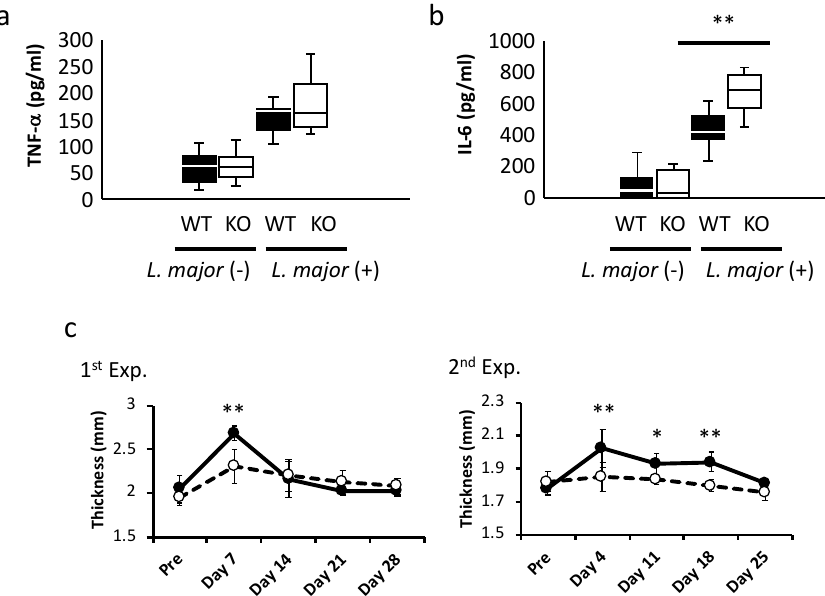
Figure 5. Leishmania ( Leishmania ) major infection in vitro and in vivo. BMDCs from WT and KO mice were infected with L. ( L. ) major . After 3 days of incubation, the culture supernatants were collected, and the concentration of IL-6 were measured by ELISA, as described in Materials and Methods. ( a ) TNF-α levels in the culture supernatants of WT (black bar) and KO (white bar) BMDCs. ( b ) IL-6 levels in the culture supernatants of WT (black bar) and KO (white bar) BMDCs. Data in both (a) and (b) are collected the data of three independent experiments each involving six mice (WT n = 3, KO n = 3) analyzed by one-way ANOVA with Bonferroni post hoc test. ** p < 0.01. WT and KO mice were infected with L. ( L. ) major (1 × 10 6 metacyclics) in footpads. ( c ) Thickness of L. ( L. ) major- infected footpads in WT (black circles) and KO (white circles) mice. The left panel shows the first experiment with 12 mice (WT n = 5, KO n = 7) and the right panel shows the second experiment with 13 mice (WT n = 6, KO n = 7) analyzed by two-way ANOVA with Bonferroni post hoc test. * p < 0.05, ** p < 0.01.